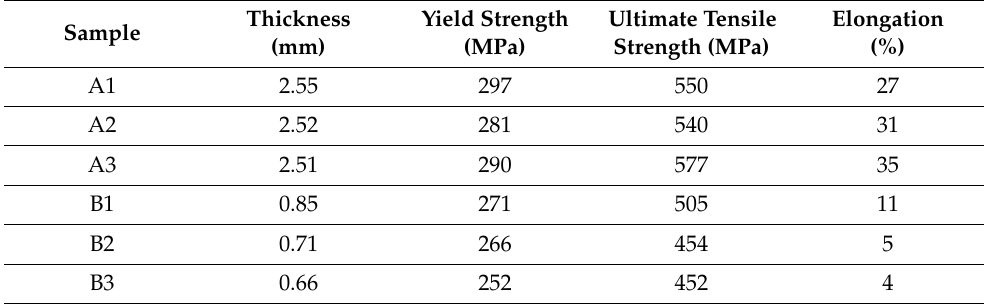
Table 1. Tensile properties of the tested samples cut from the used C-276 pipe